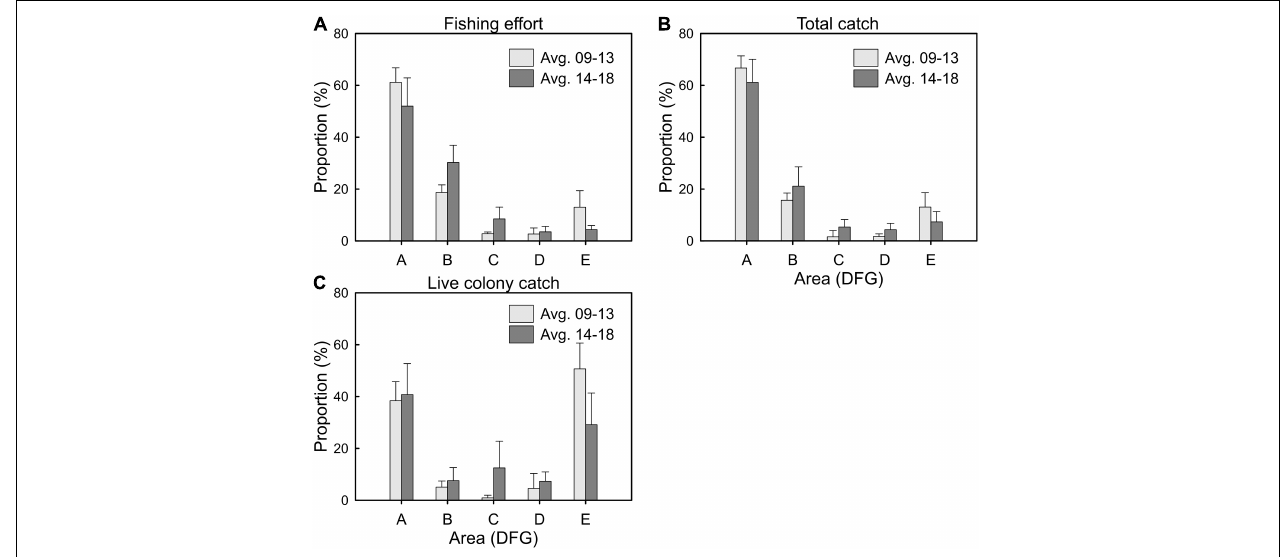
FIGURE 6 | Average annual proportion (%) of the DFGs for the (A) fishing efforts, (B) total catches, and (C) live colony catches of the Taiwanese precious coral fishery from 2009 to 2013 and 2014 to 2018 (error bar, standard deviation).